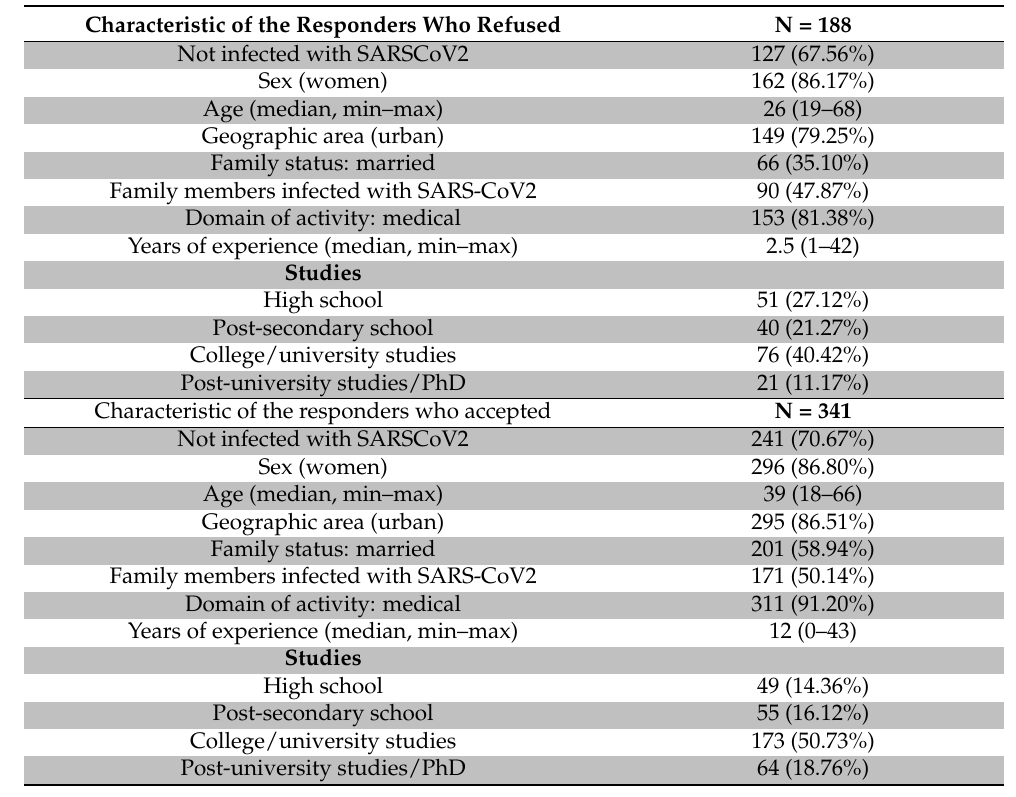
Table 3. Main characteristics of the responders who refused and accepted COVID-19 vaccination.